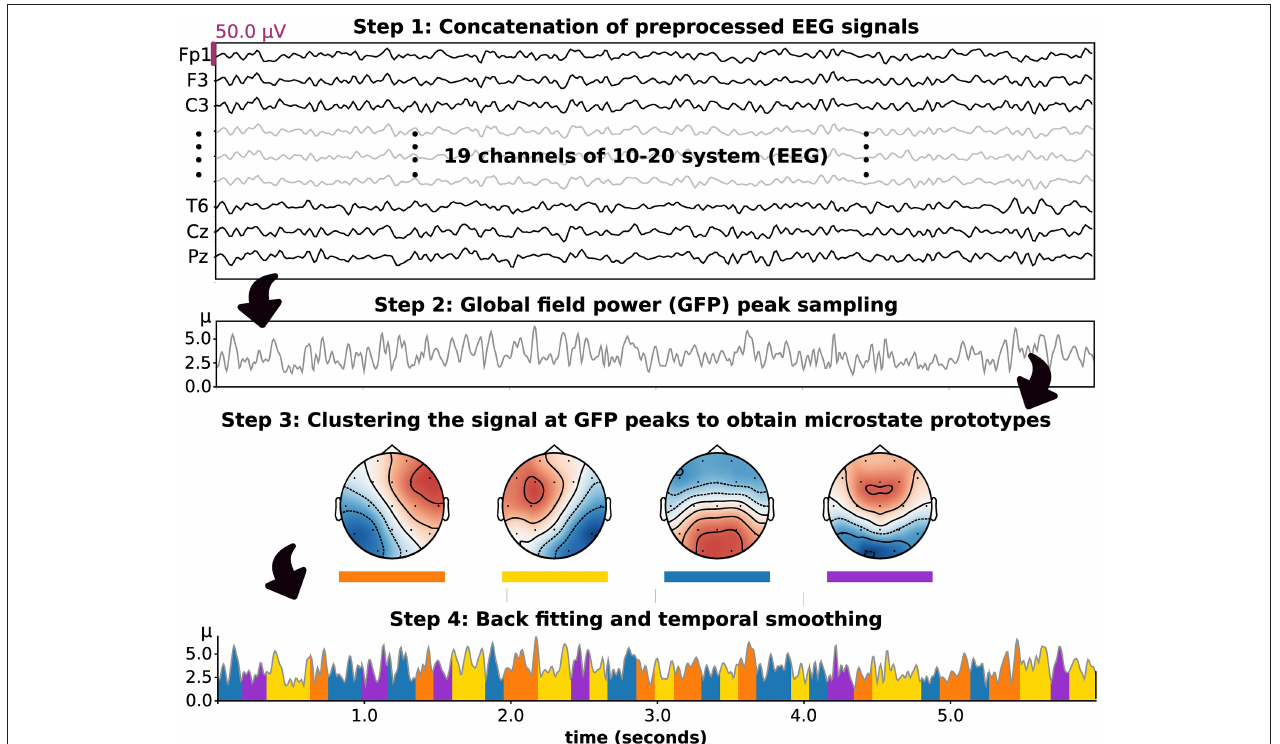
FIGURE 1 | The stepwise methodology of microstate analysis introduced based on the application in this study. Four prototypes were set and included in clustering, backfitting, and temporal smoothing.